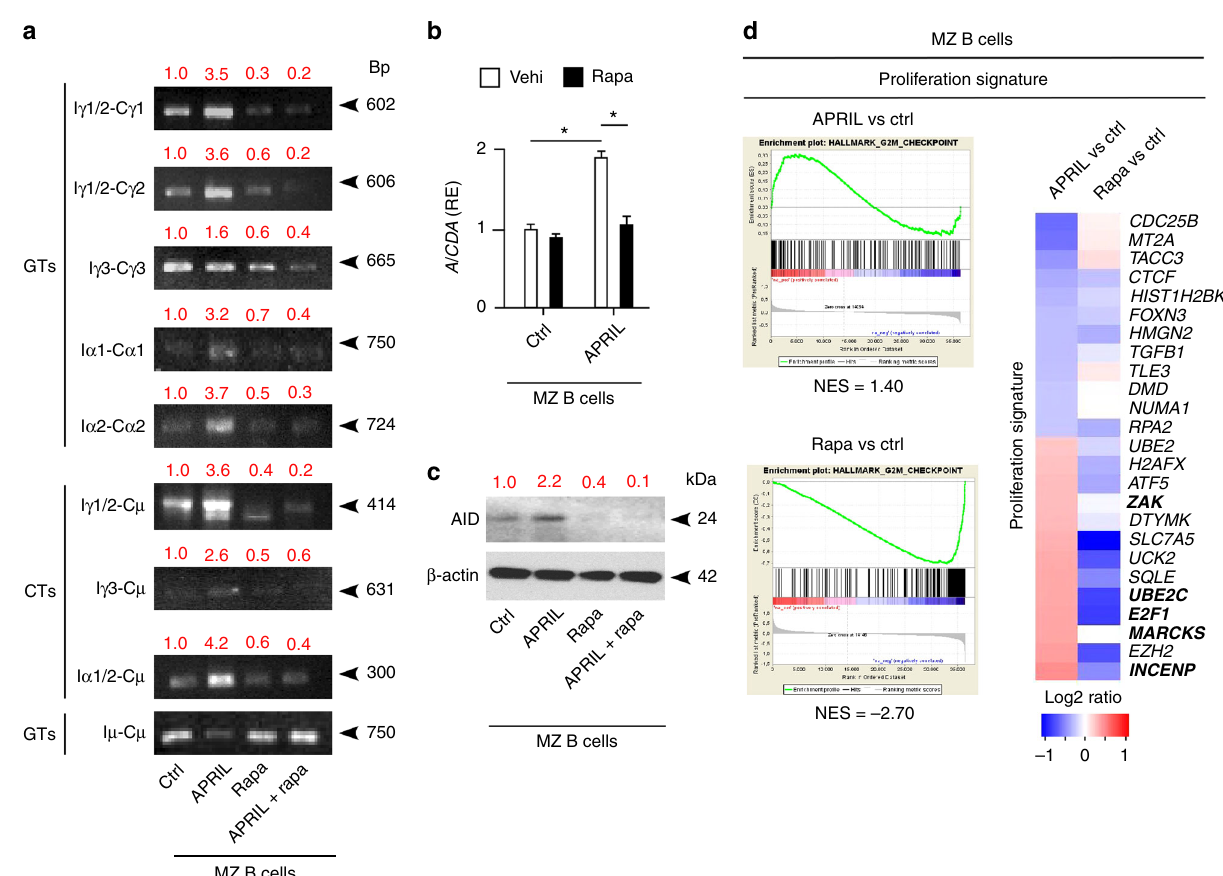
Fig. 5 TACI triggers CSR by cooperating with TLR9 through mTORC1. a PCR analysis of I γ 1/2-C γ 1, I γ 1/2-C γ 2, I γ 3-C γ 3, I α 1-C α 1, I α 2-C α 2 and I µ -C µ germline transcripts (GTs) as well as I γ 1/2-C µ , I γ 3-C µ , I α 1/2-C µ switch circle transcripts (SCTs) RT-PCR-ampli fi ed from human splenic MZ B cells incubated with APRIL in the presence or absence of rapamycin (rapa) for 3 days. Red numbers indicate band intensity relative to I µ -C µ bands. b qRT-PCR of mRNA for AID ( AICDA ) from human splenic MZ B cells incubated with APRIL in the presence of control vehicle (vehi) or rapamycin for 3 days. Results are normalized to β -actin mRNA and presented as relative expression (RE) compared to B cells incubated with medium alone (Ctrl). c IB of AID and β -actin from human splenic MZ B cells treated as in a . Red numbers indicate band intensity relative to β -actin. d GSEA showing enrichment or depletion of coordinated proliferation-related gene sets from human splenic MZ B cells cultured for 3 h with or without APRIL or rapamycin. Ctrl, medium alone. NES indicates correlation between individual gene sets. Positive correlation, NES > 0; negative correlation, NES < 0. Heat map showing top 25 genes similarly enriched or depleted in MZ B cells exposed to different treatments. Colors correspond to signi fi cant FC expression: red, high expression; blue, low expression. Bold indicates gene products discussed in the text. Data represent one of three experiments with similar results ( a , c ), summarize three experiments ( b ) or correspond to one experiment with three biological replicates ( d ). Error bars, s.e.m.; * p < 0.05, ** p < 0.01 (two-tailed Student ’ s t